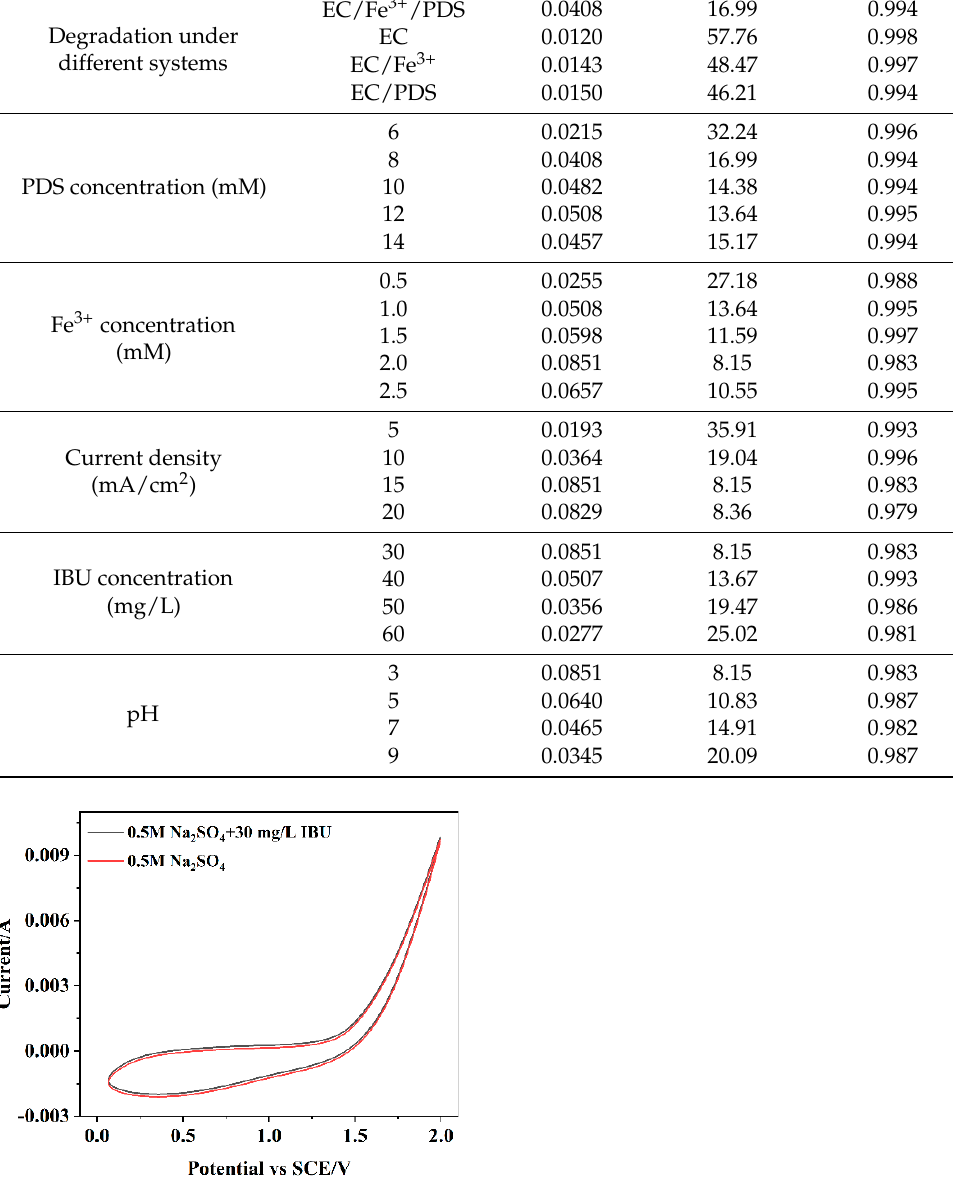
Figure 2. Cyclic voltammograms of RuO 2 -IrO 2 /Ti in 0.5 mol/L Na 2 SO 4 solutions in the presence and absence of IBU (30 mg/L) at a scan rate of 10 mV/s. Table 1. The kinetics for IBU degradation in the EC/Fe 3+ /PDS system .